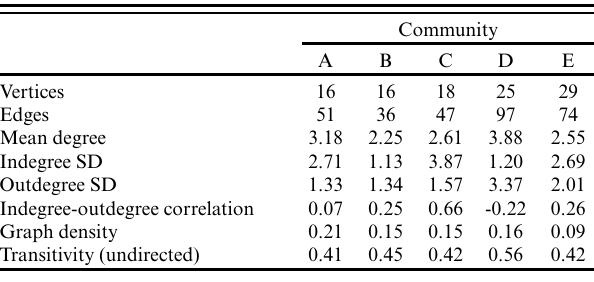
Table 2 . Network descriptives of the five communities. SD, standard